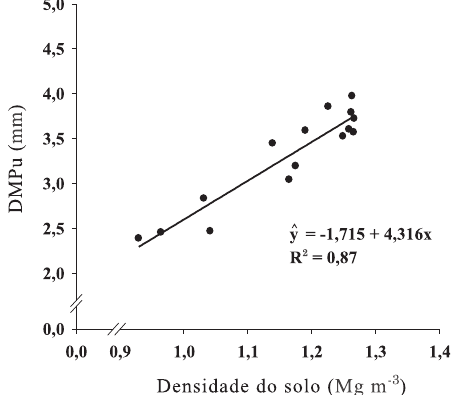
Figura 4. relação entre densidade do solo e diâmetro médio ponderado úmido (dMpu) de agregados de um latossolo Vermelho sob sistemas de culturas em plantio direto, considerando as camadas de 0–5, 5–10 e 10–20